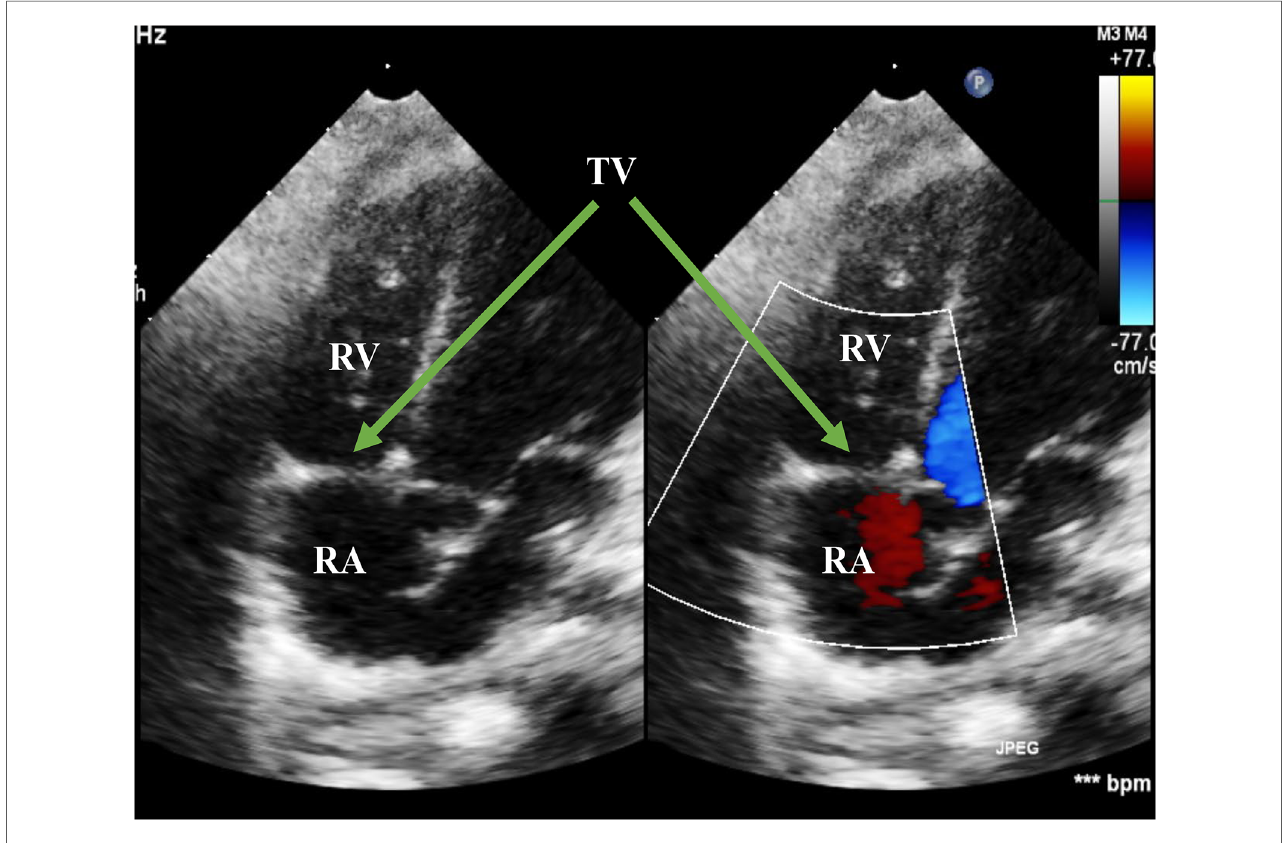
FIGURE 6 Echo at the latest visit in the A4C view. The fi gure showed normal movement of the anterior lea fl et of the TV in the systolic phase. RA, right atrium; RV, right ventricle; TV, tricuspid valve; A4C, apical